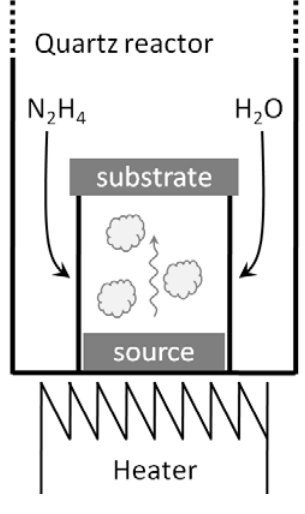
Figure 11. Cylindrical quartz reactor for nanowire